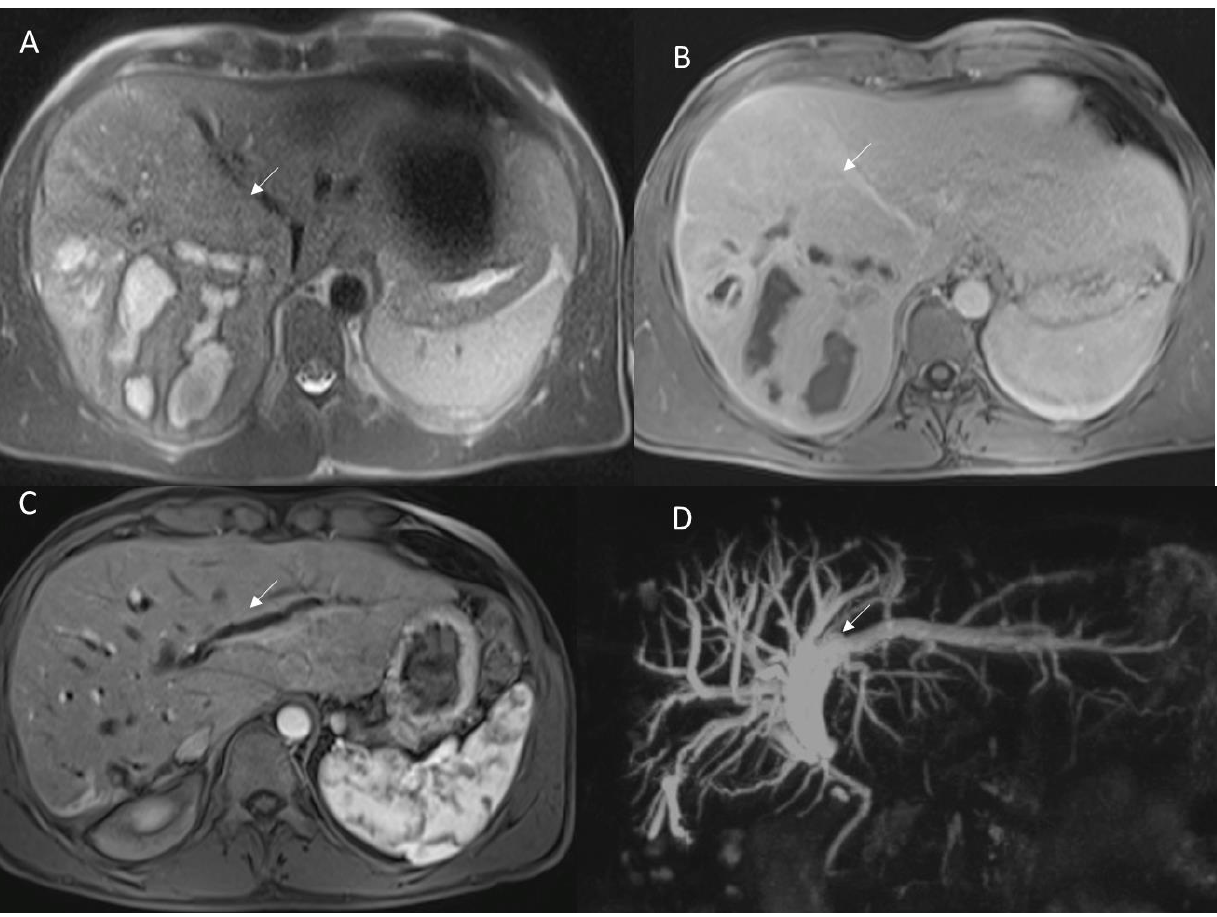
Figure 9. Patient with hepatosarcoma evaluated with MRI study (( A ): T2-W sequence and ( B ): portal phase of contrast study). At MRI 6-month evaluation of arterial phase ( C ) and cholangiography ( D ) sequences show biliary strictures (arrow).